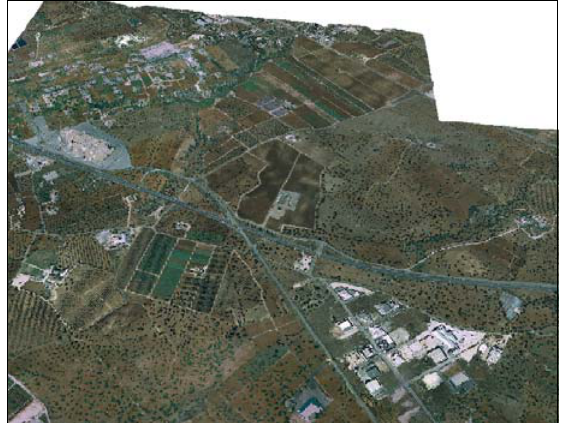
Figure 4. DEM and ortophoto drapping (test 2)